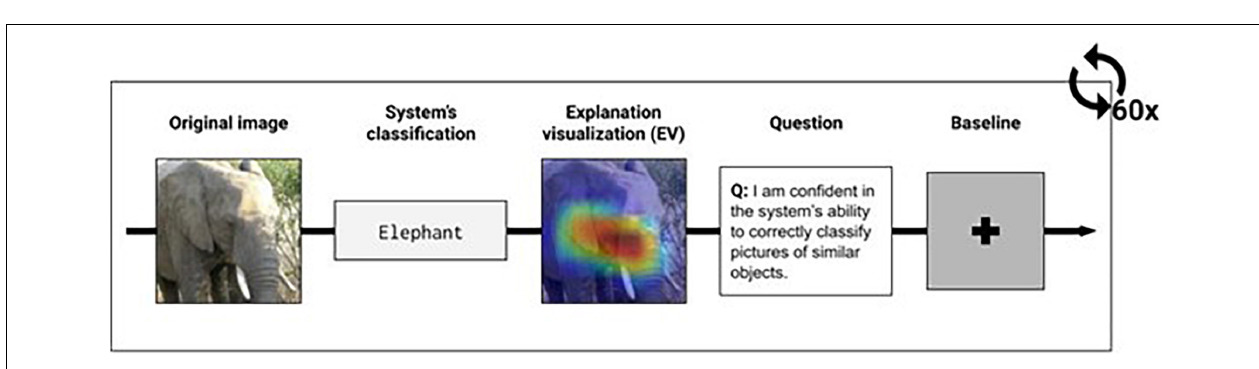
FIGURE 2 | Task’s design. Images selected from the ImageNet dataset (Deng et al., 2009).